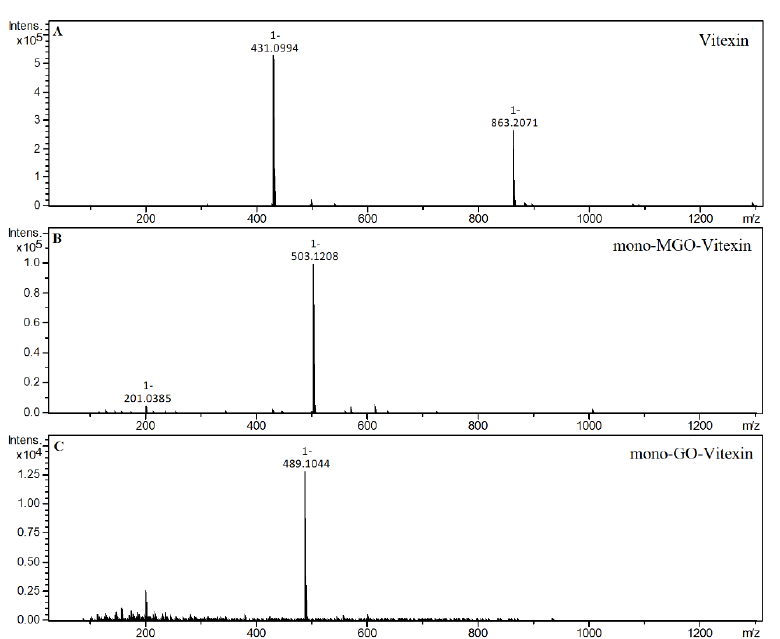
Figure 9. Mass spectra of vitexin and its methylglyoxal/glyoxal adducts after 1 h of incubation in 7.4 phosphate buffer solution at 37 ◦ C; ( A ), vitexin; ( B ), mono-MGO-vitexin; ( C ), pH 7.4 phosphate buffer solution at 37 °C; ( A ), vitexin; ( B ), mono-MGO-vitexin; ( C ), mono-GO-vi- texin.